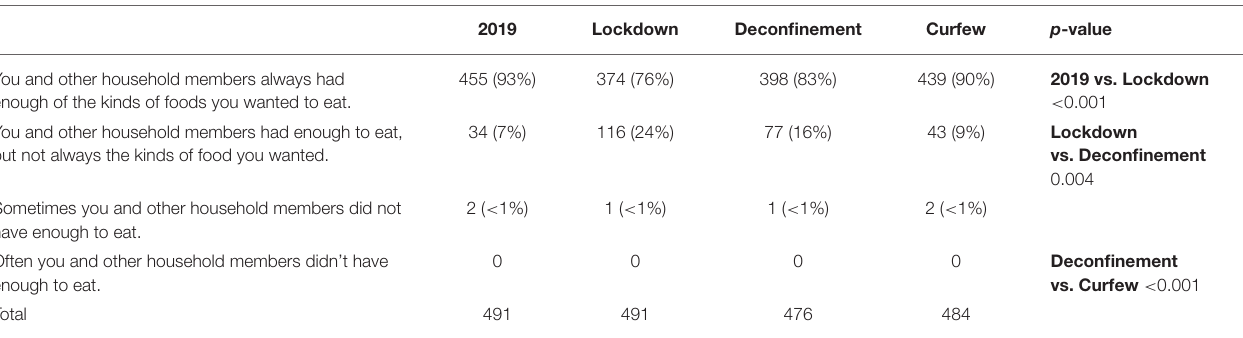
TABLE 4 | Changes in household food